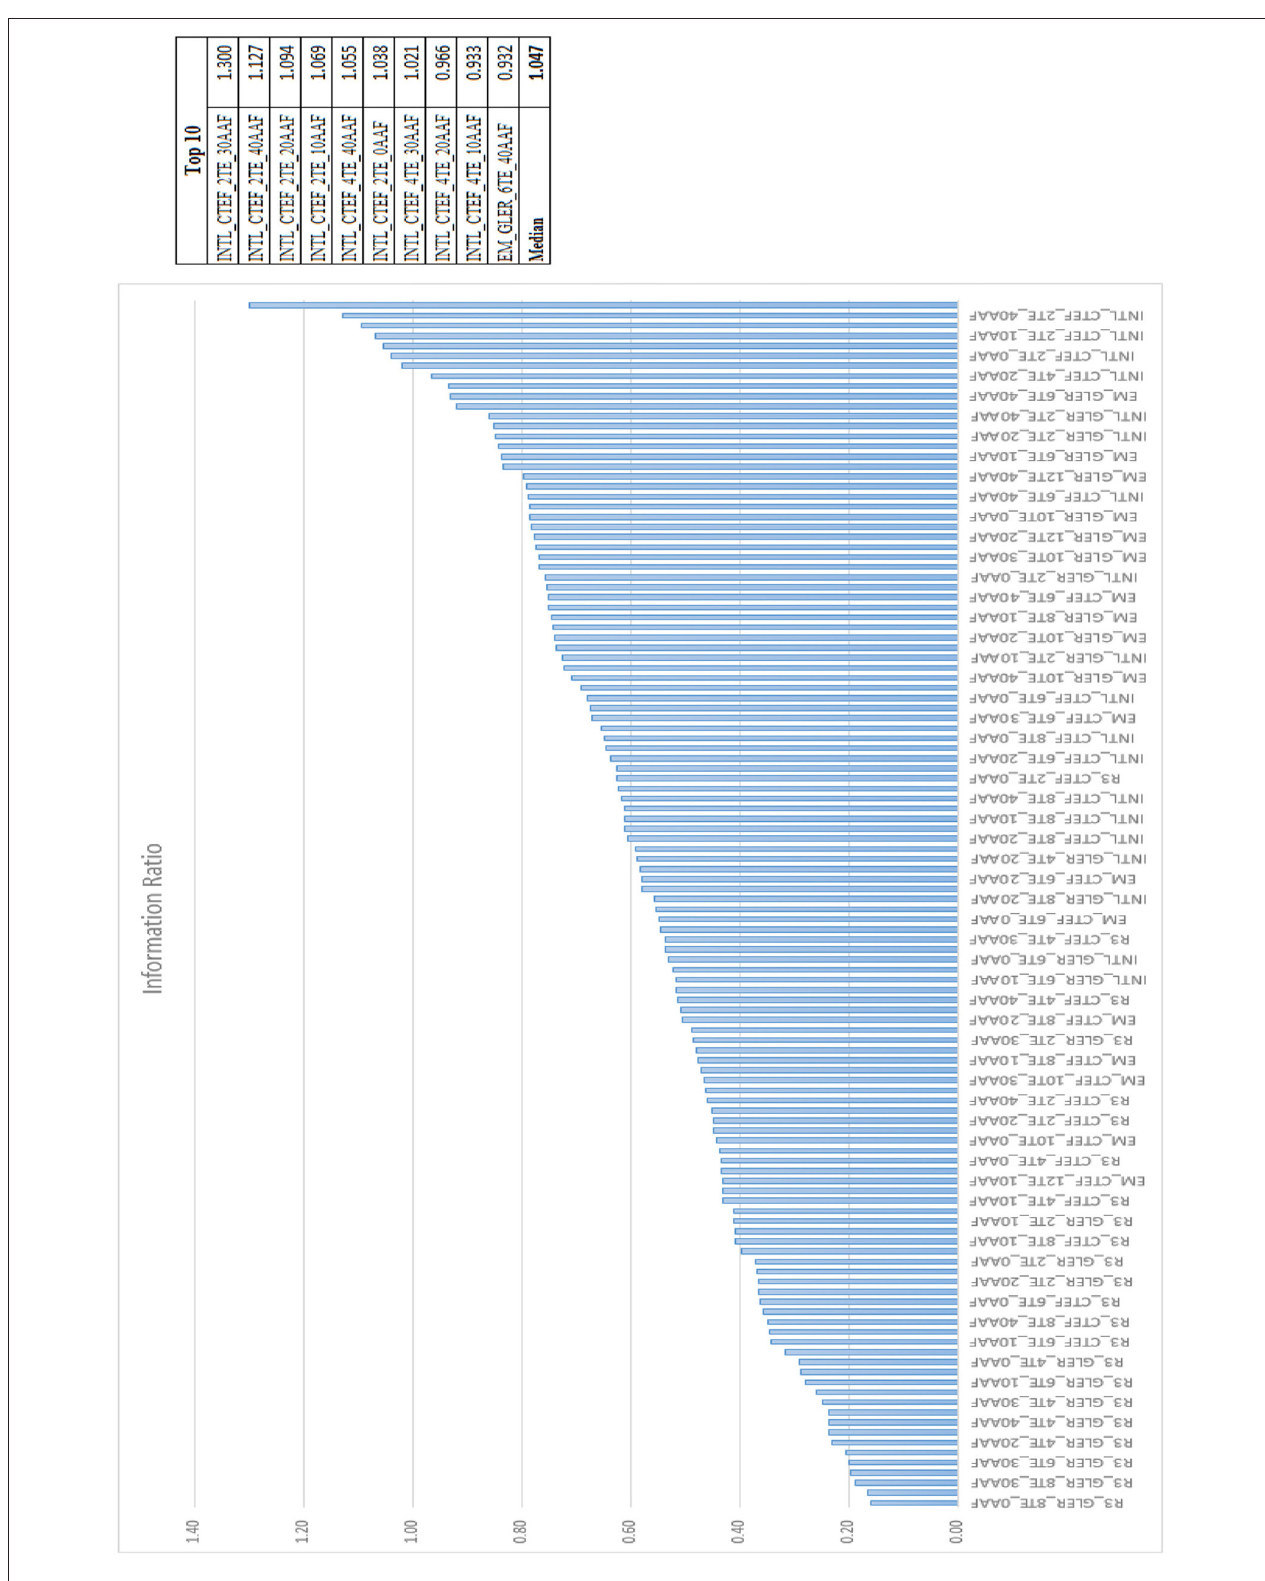
FIGURE 5 | Information